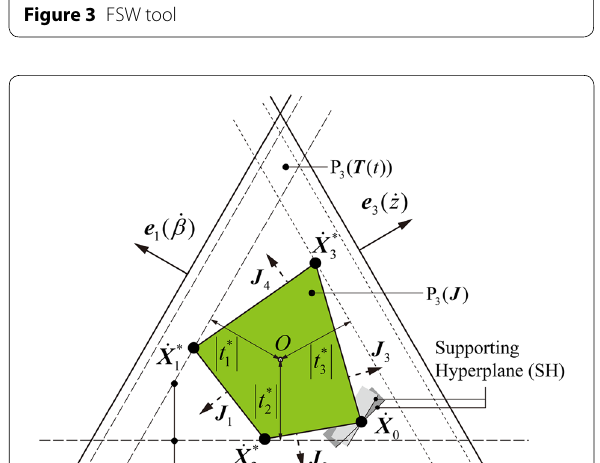
Figure 3 FSW tool